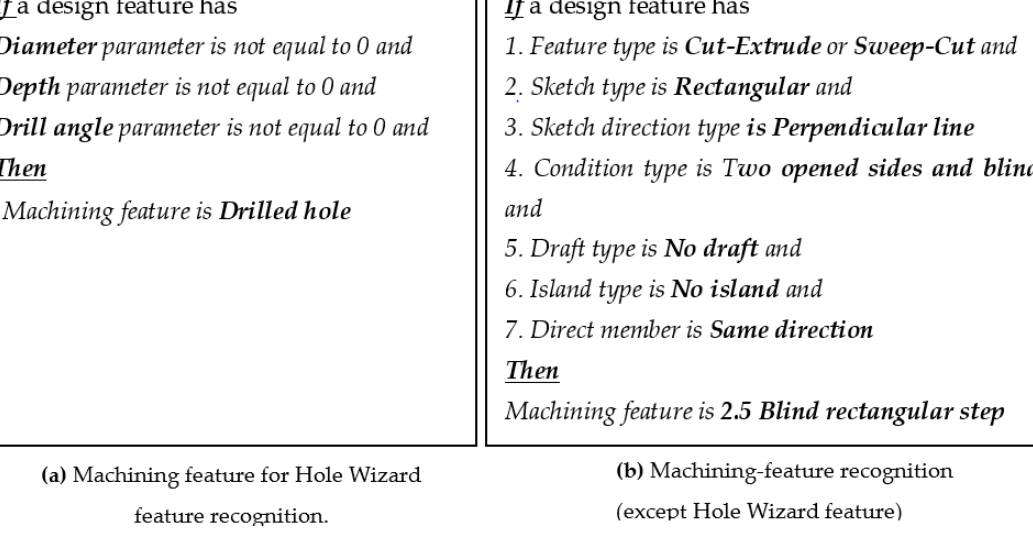
Figure 2. Examples of machining feature recognition rules.